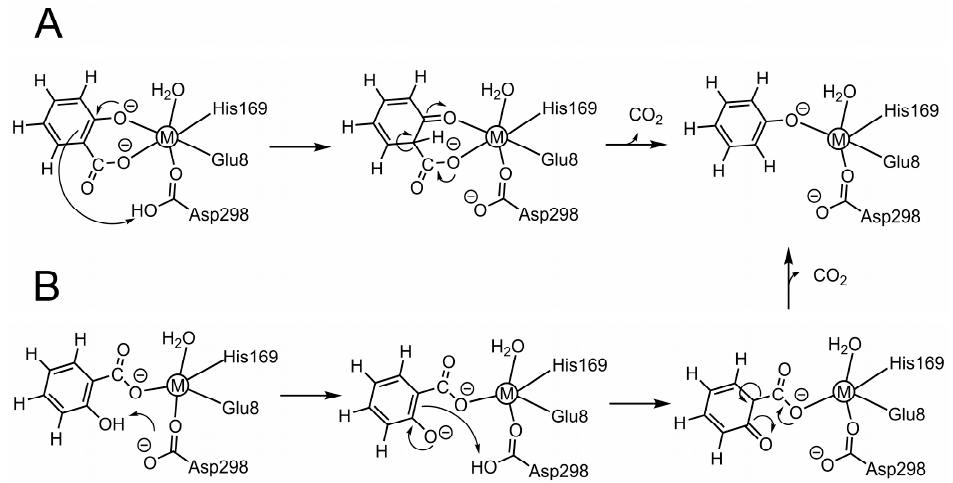
Scheme 2. ( A ) The proposed mechanism of SDC reaction on the basis of calculations in the present study. ( B ) The previously proposed mechanism [19].